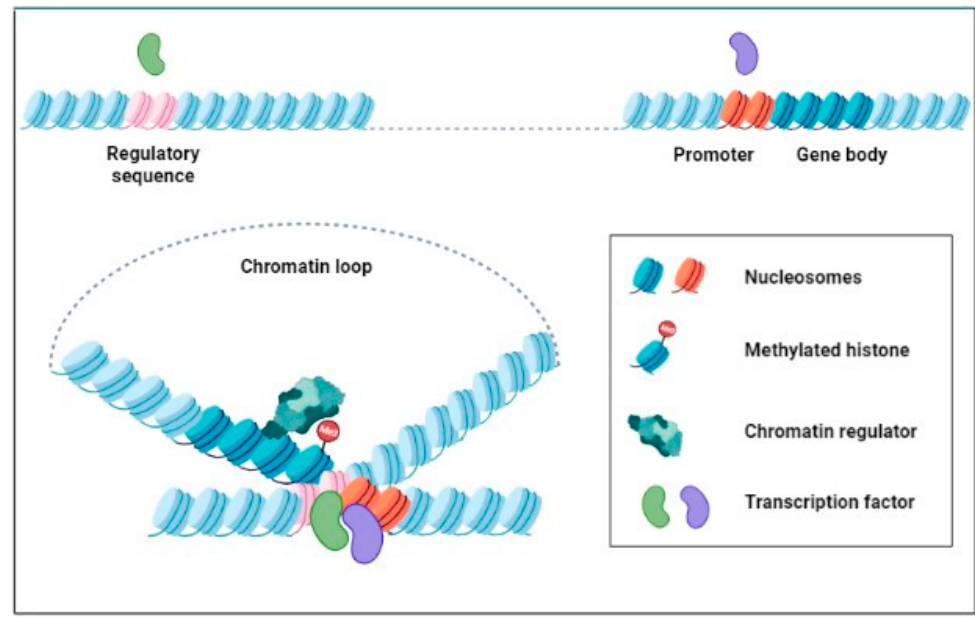
Figure 3. Hypothetical mechanism of mitotic transmission for transcriptional memory. In response to stress, long-range chromatin loops are formed by the interactions of multiple transcription factors that bind to distant regulatory sequences (e.g., enhancer, silencer, or regular protein binding sites) and the counterpart promoters, thereby enhancing or suppressing gene transcription. The chromatin loop can persist throughout the cell division cycle or dissolve during mitosis but reassemble following cell division. The chromatin of a memory locus may remain accessible to epigenetic marks (e.g., H3K27me3 or H3K4me3) and chromatin regulators (e.g., PcG complexes or TrxG complexes), thus bookmarking the locus for subsequent transcriptional status (e.g., silencing or activation). Histone octamers wrapped by DNA at the regulatory region (pink), promoter (orange), and gene body (deep blue) are represented, respectively, with different colors.